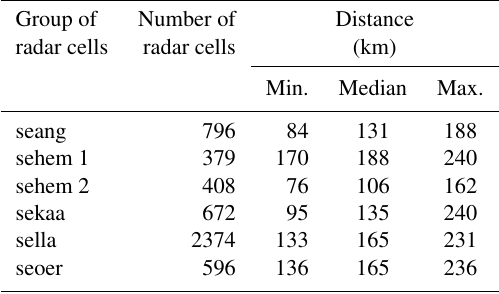
Table 3. Number of radar cells in the selected regions, together with minimum, median, and maximum distances to these